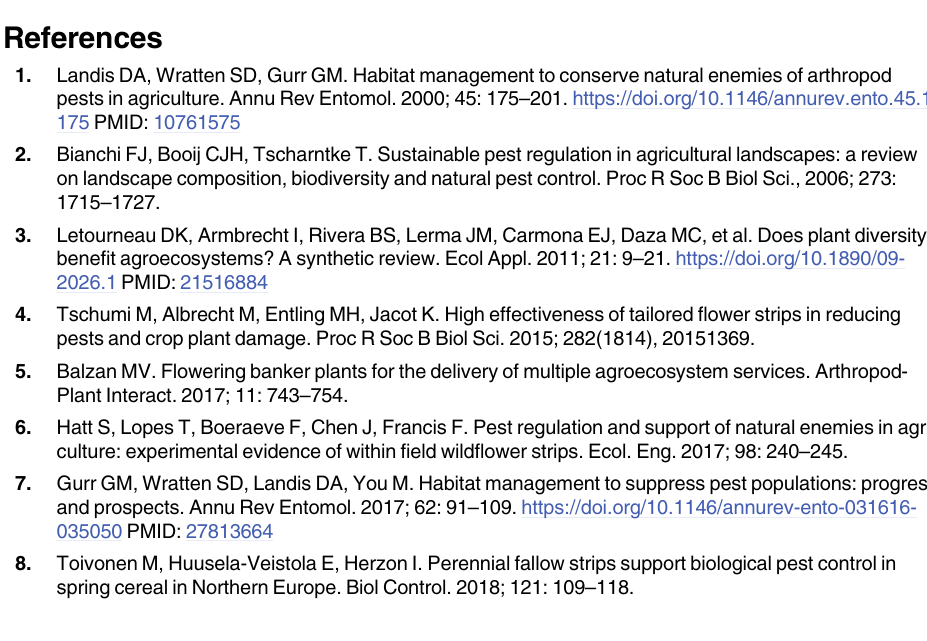
S2 Table. Predator occurrence in test arrays Summer 2017 experiment. S3 Table. Predator occurrence in test arrays Summer 2018